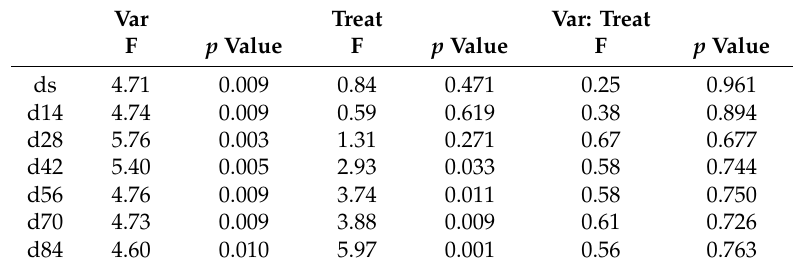
Table 2. E ff ect of singular and combined e ff ect of variety x treatment interaction on the branches’